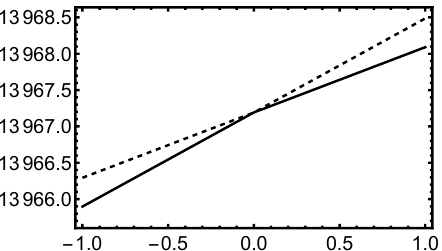
Figure 2. Effect of the perturbation of the Young’s modulus on the smallest eigenvalue. The x -axis is the constant value given to all random variables Y m . The solid line traces the smallest or effective smallest eigenvalue, the dashed line the second smallest one.